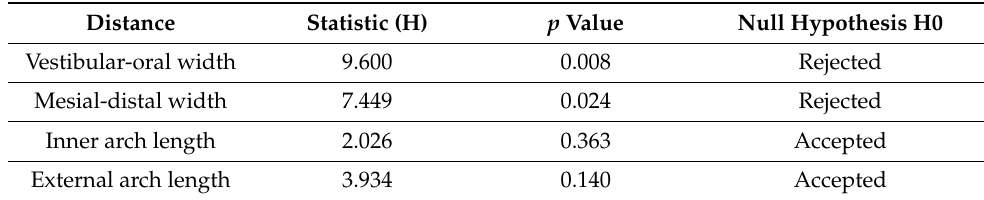
Table 2. Hypothesis testing results of the